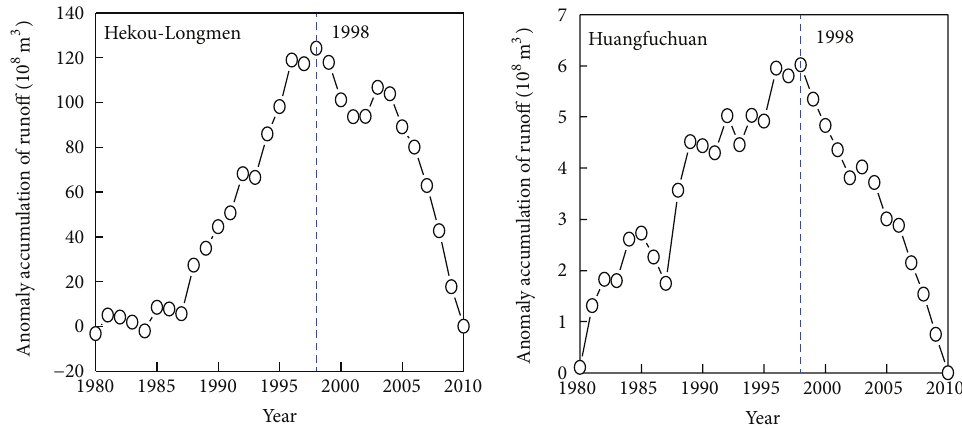
Figure 4: Accumulative anomaly curve of runoff in the Hekou-Longmen region and Huangfuchuan during 1980–2010.